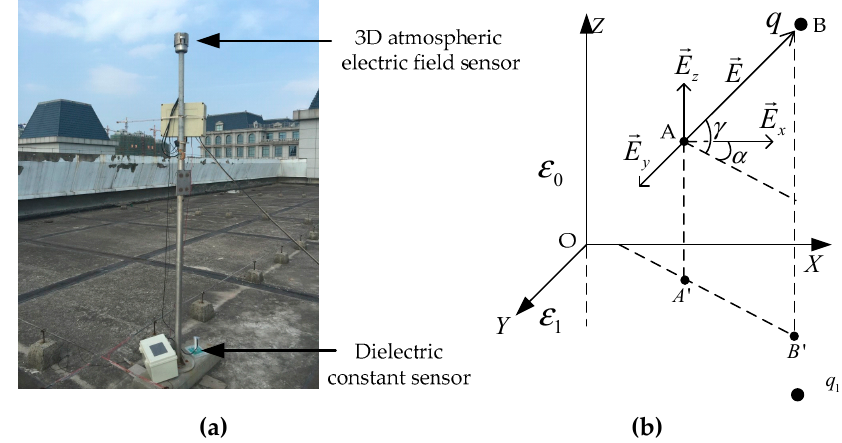
Figure 2. Observation experiment and model of the three-dimensional atmospheric electric field meter. ( a ) Installation of a three-dimensional atmospheric electric field meter; ( b ) observation model.